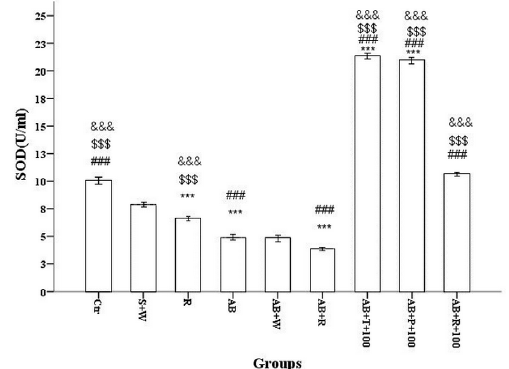
FIGURE 1 - Overall serum level of SOD in different groups.